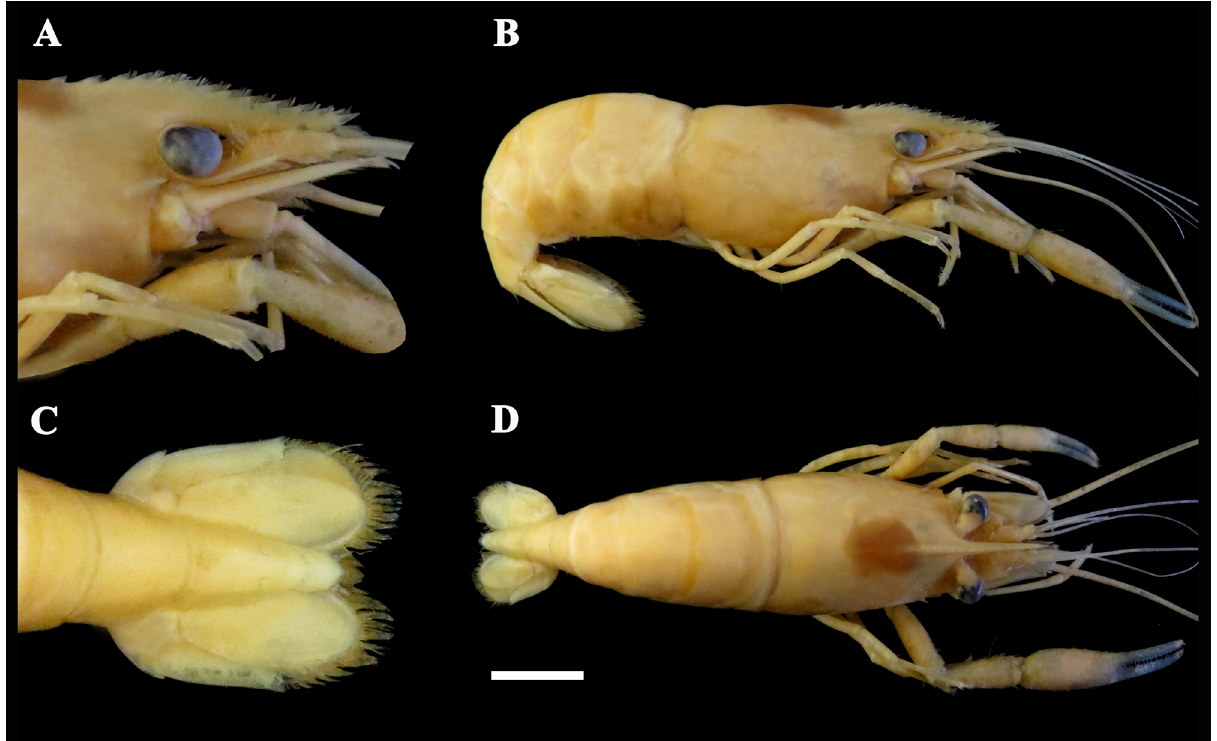
Figure 6. Macrobrachium olfersii (Wiegmann, 1836), female (LSZ 075). A, Detail of the anterior region of the carapace; B, habitus, lateral view; C, detail of the telson and uropods, dorsal view; D, habitus, dorsal view. Scale bar: 1